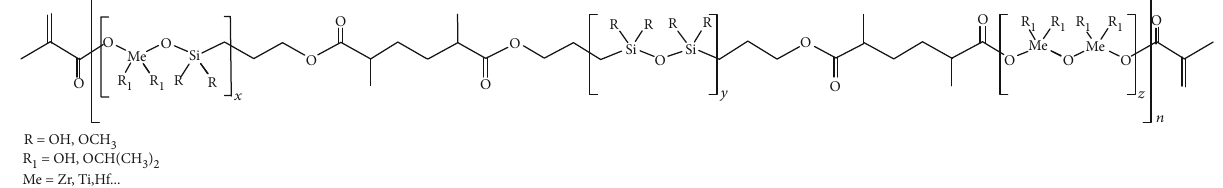
Figure 7: Structural formula of hybrid organic-inorganic polymer consisting of MAPTMS and metal isopropoxide. Here x , y , and z are degrees of inorganic polycondensation.